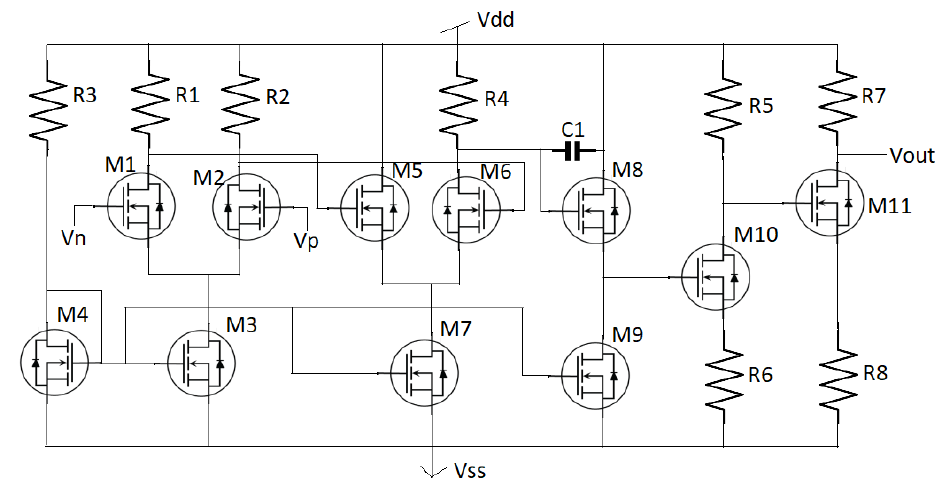
Figure 2. Proposed gallium nitride (GaN) operational amplifier. Exact values of the components cannot be shown here due to confidentiality pertaining to patent filing.